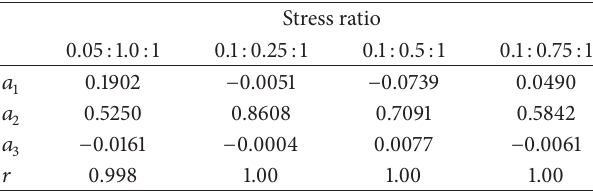
Table 6: The value of 𝑎 1 , 𝑎 2 , 𝑎 3 , and 𝑟 . Stress ratio